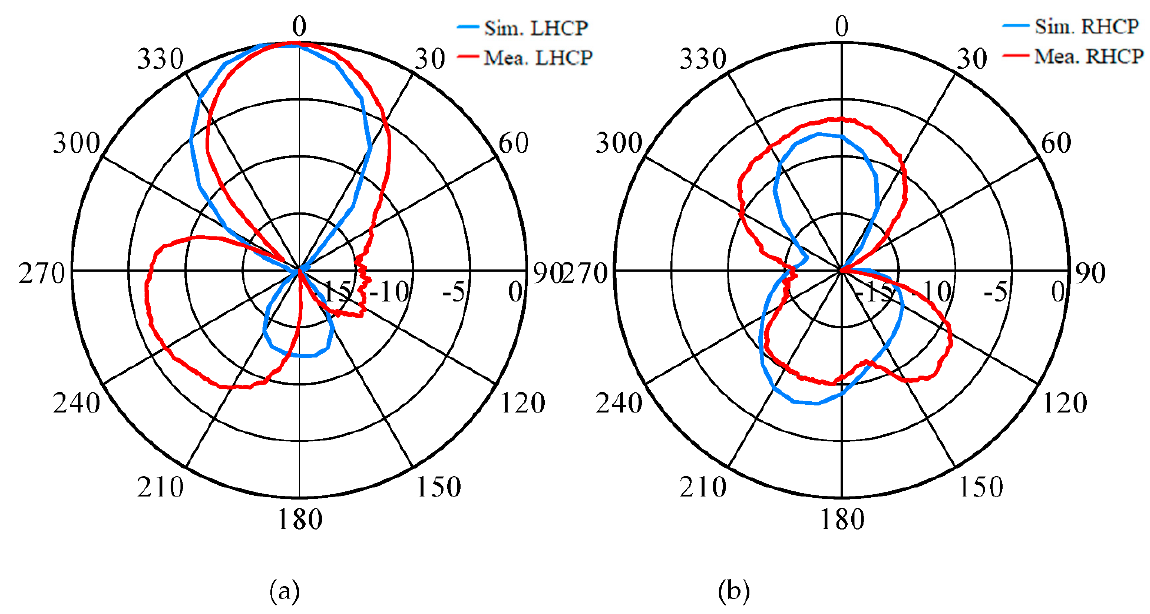
Figure 12. Radiation pattern @ 9.0 GHz: ( a ) LHCP (xz-plane) and ( b ) RHCP (xz-plane).